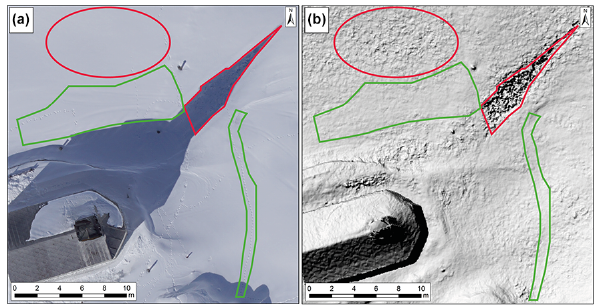
Figure 9. Winter orthophoto of the area close to the chapel within the test site Tschuggen (a) and hillshade of the derived DSM (b) . Areas in red show very homogeneous snow surfaces either in cast shadow or nearly saturated areas. Areas marked in green are areas with better contrast at the snow surface due to tracks of animals or wind